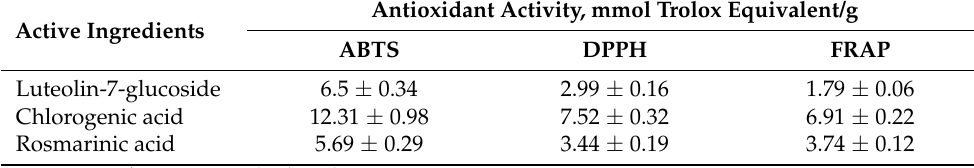
Table 4. Antioxidant properties of BASs from T. vulgare extracts. Active